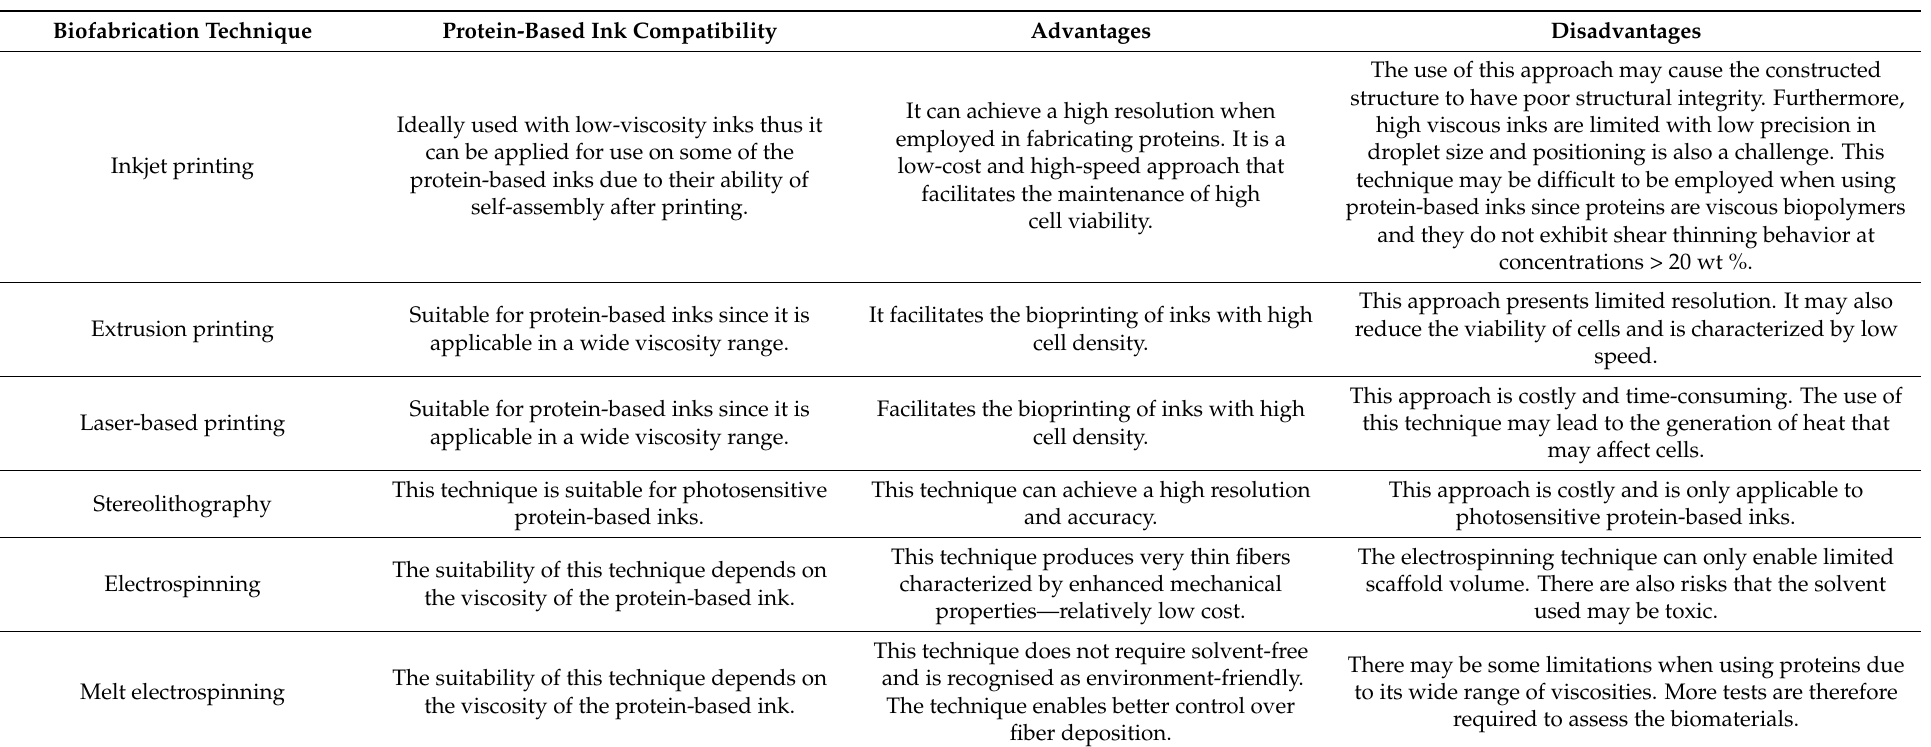
Table 2. Comparison of biofabrication techniques used for protein-based inks